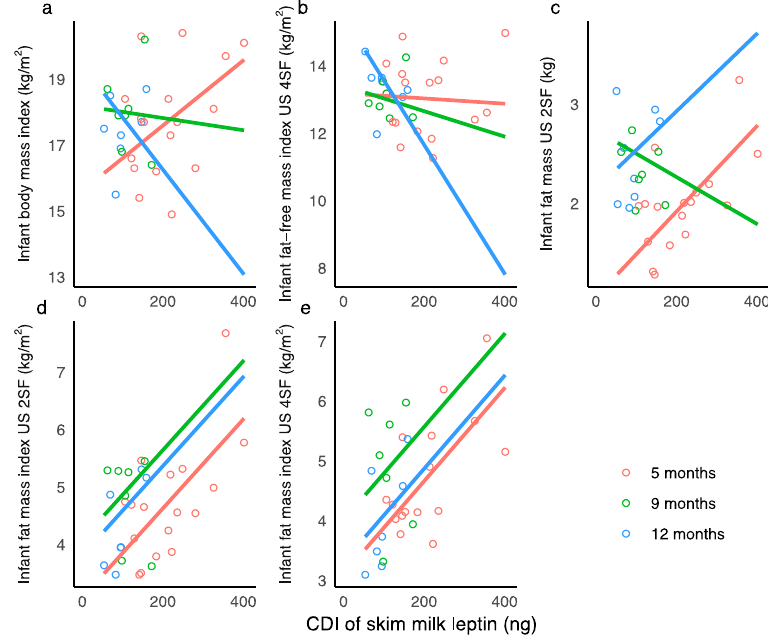
Figure 3. Significant associations between calculated daily intakes (CDI) of skim milk leptin. ( a ) Infant body mass index; ( b ) infant fat-free mass index measured with ultrasound 4-skinfolds (US 4SF); ( c ) infant fat mass with US 2-skinfolds (US 2SF); ( d ) infant fat mass index with US 2SF; ( e ) infant fat mass index with US 4SF. Lines represent linear regression and grouped by the month of lactation.